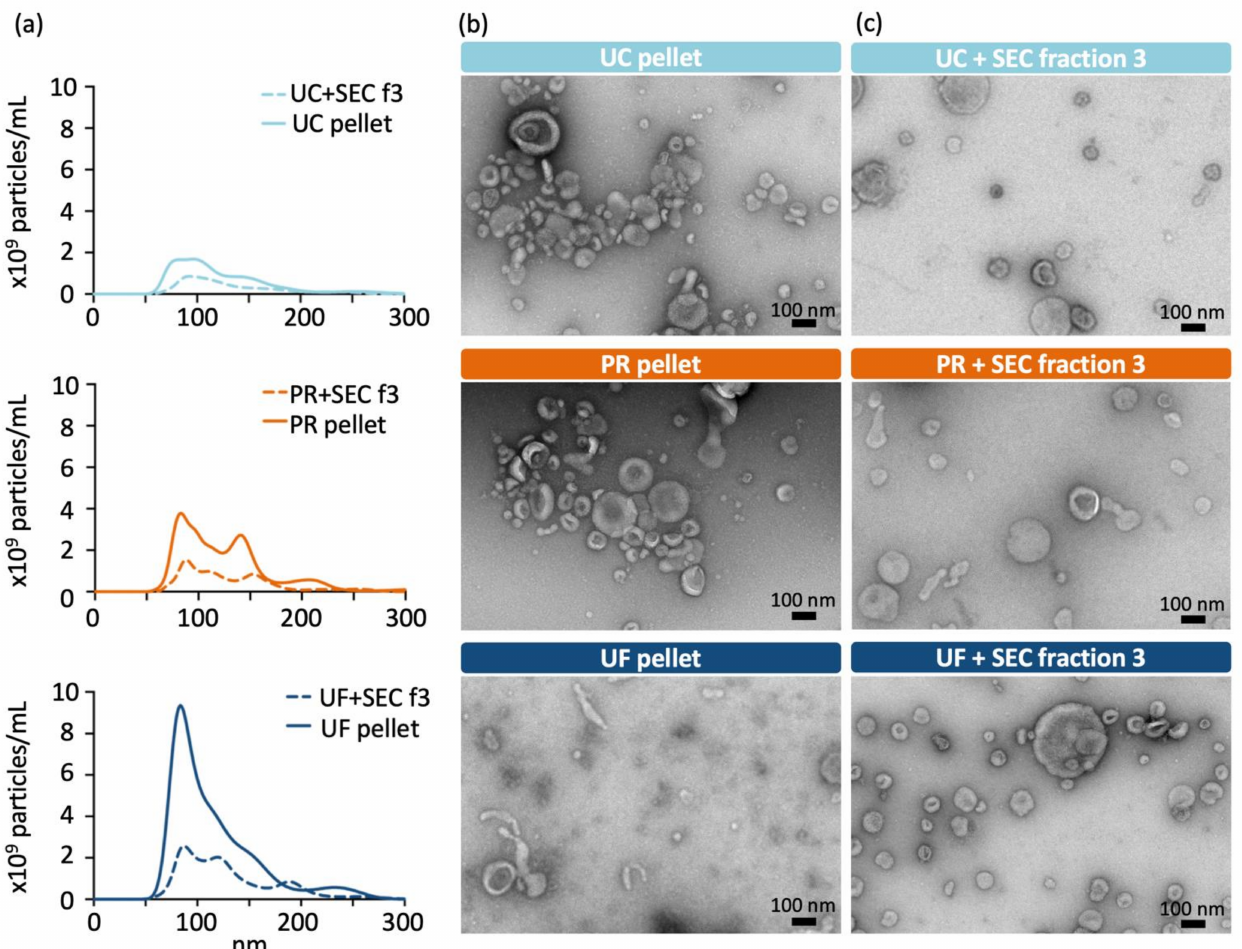
Figure 3. Characterisation of EV size profiles and morphology: ( a ) Particle size distributions measured with nanoparticle tracking analysis (NTA) from ultracentrifugation (UC), precipitation-based kit (PR) and ultrafiltration (UF) samples before and after size-exclusion chromatography (SEC) purification. Mean of three 60 s recordings is shown. Transmission electron microscopy (TEM) images of purified or concentrated EVs ( b ) before and ( c ) after the SEC